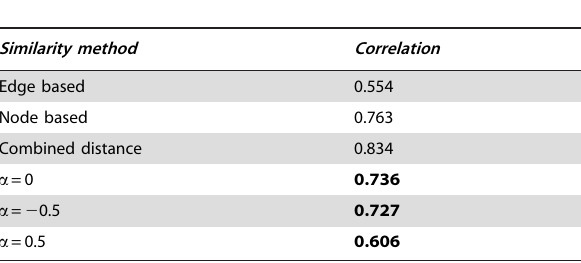
Table 2. Word-pair semantic similarity measurement. Table 3. Pearson’s correlation coefficients between similarity ratings and the average ratings reported by Miller and Charles [43] for the subset of pairs listed in Table